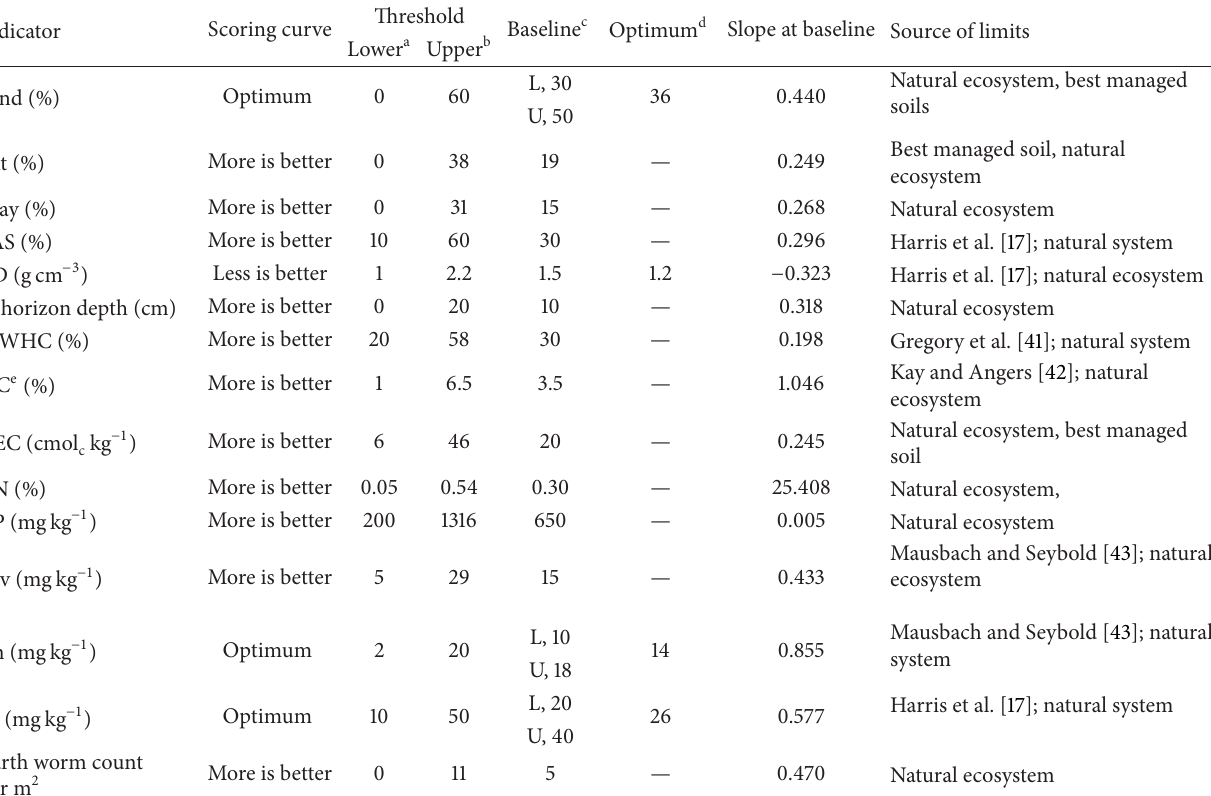
Table 3: Soil quality indicators, scoring curve, and threshold and baseline limits used for evaluating eight LUSMS in northern Ethiopia. Indicator